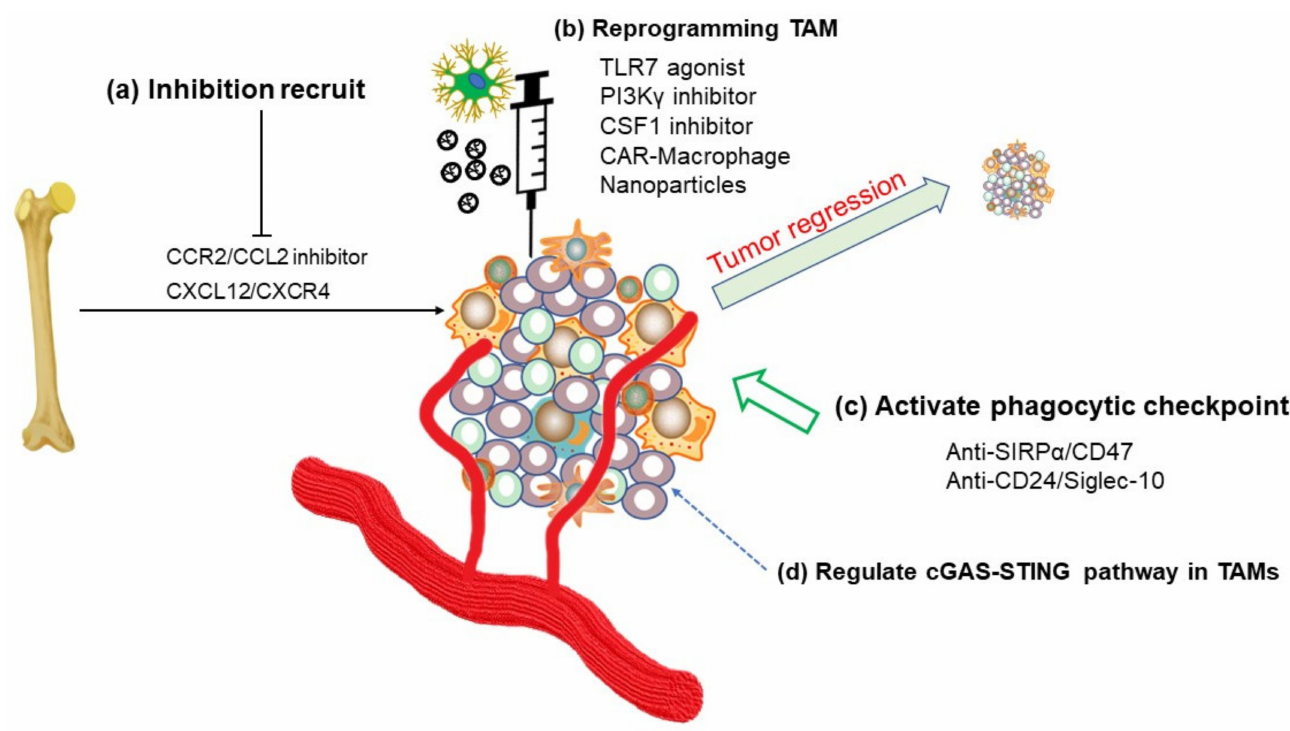
Figure 4. TAM-targeted therapy in tumors. Targeting TAM strategies consists of ( a ) the inhibition of the recruitment of macrophages to tumor mass; ( b ) reprogramming TAMs into M1-like macrophages to strengthen antitumor ability ( c ) the activation of “phagocytic checkpoint” to restore macrophage phagocytic function; and ( d ) targeting cGAS-STING pathway in TAMs is a potential anti-tumor